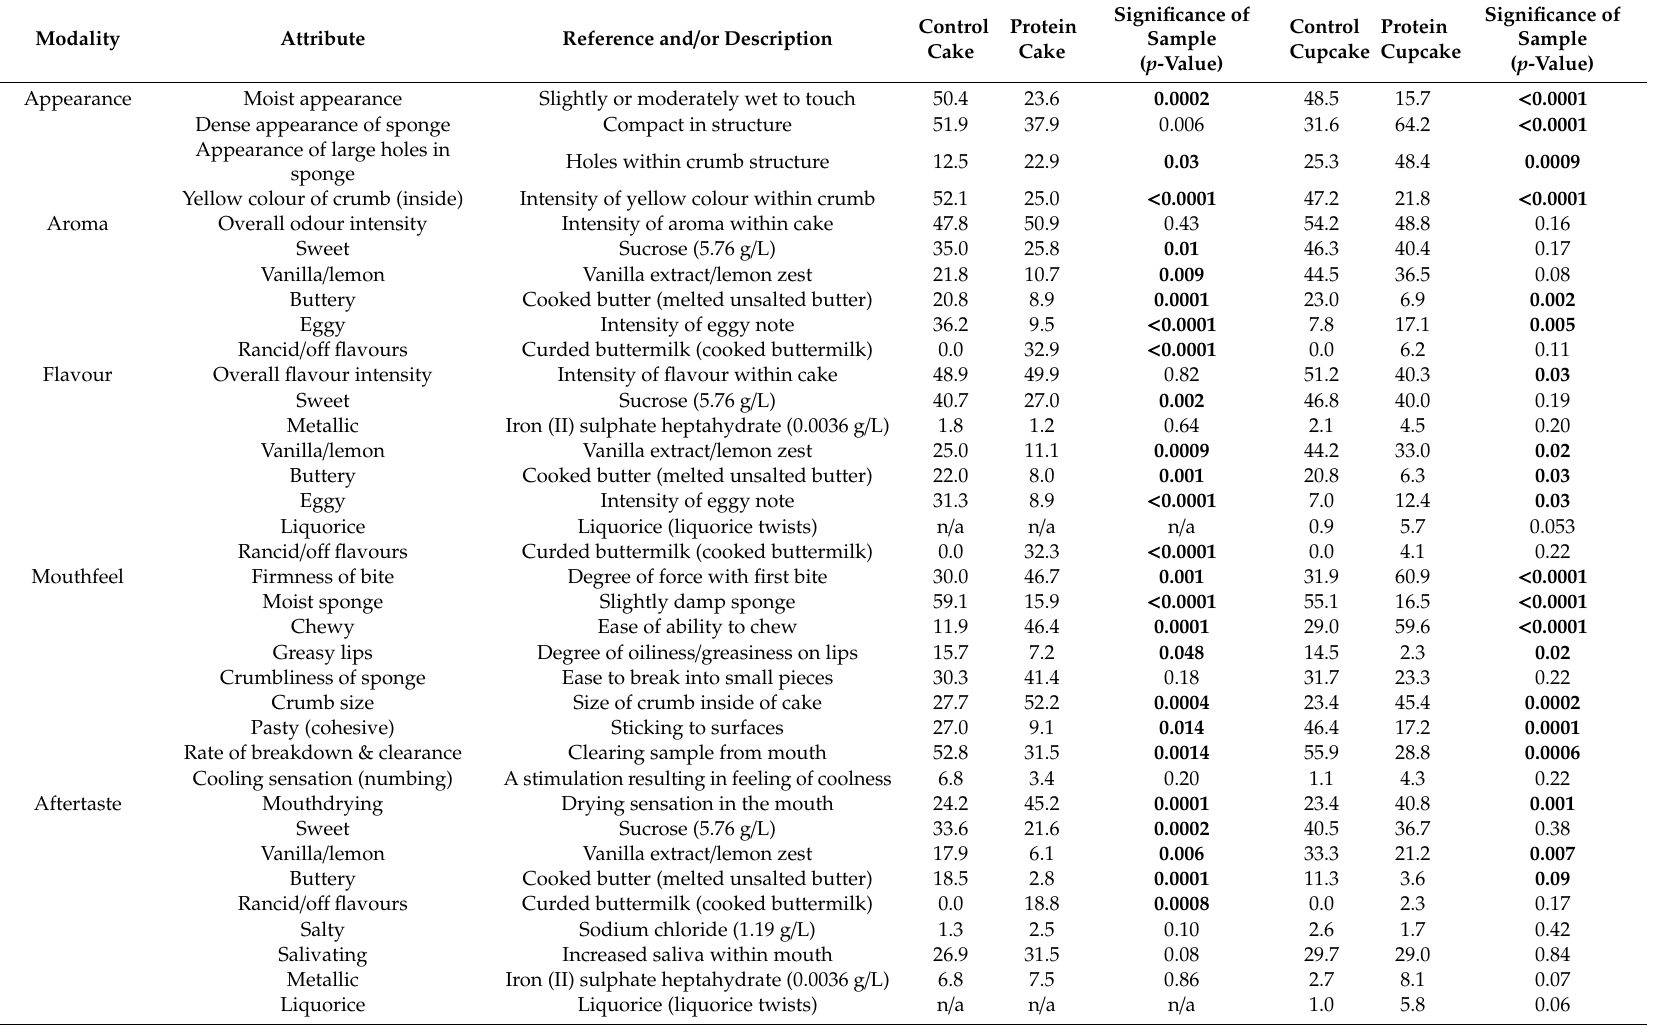
Table 2. Summary of sensory profile with corresponding reference / description and results for cakes and cupcakes. Values are expressed as means (measured on a visual analogue scale (VAS,